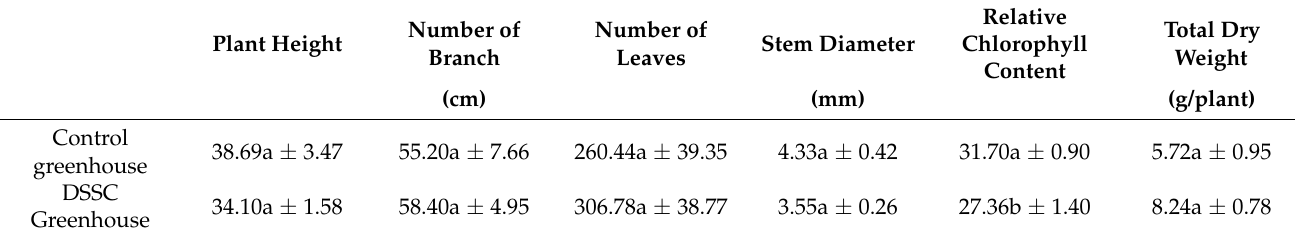
Table 5. Effect of light manipulation on growth of Orthosiphon stamineus (Misai Kucing) cultivated under glass (control) and DSSC greenhouses.